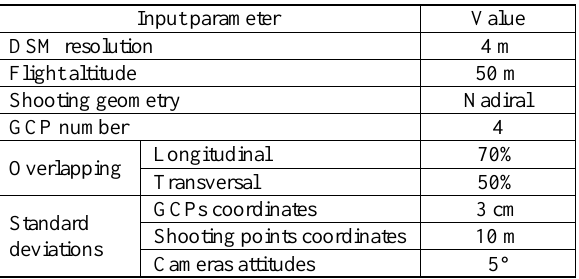
Table 1. U.Ph.O. input parameters for the two case